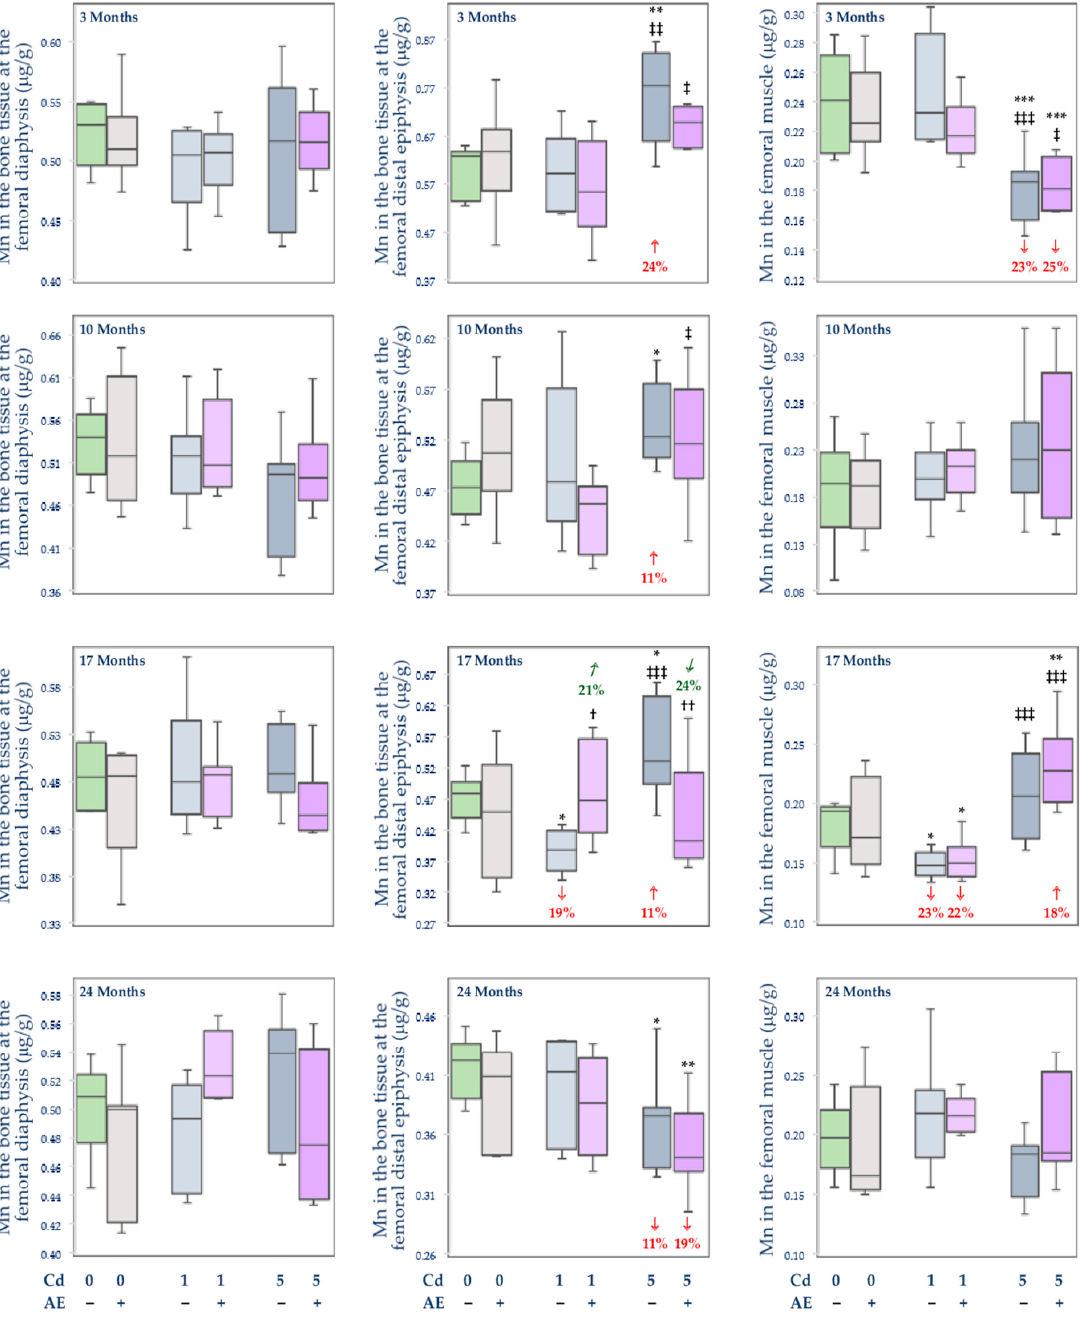
Figure 6. The concentration of Mn in the bone tissue and femoral muscle in particular experimental groups. The rats received Cd in the diet at the concentration of 0, 1, and 5 mg/kg and/or 0.1% AE as the only drinking fluid (“+”, administered; “ − ”, without administration). Data represent a median and 25–75% confidence interval (the horizontal lines within the bars presenting the confidence interval represent median values), as well as the minimum and maximum values for eight rats in each experimental group (except for seven animals in the AE, Cd1, and Cd5 groups after 24 months). Statistically significant differences: * p < 0.05, ** p < 0.01, *** p < 0.001 vs. control group; † p <